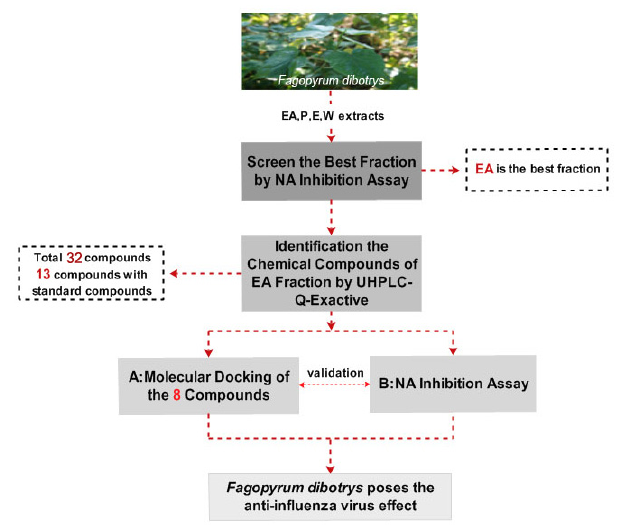
Figure 1. The flowchart of the paper.